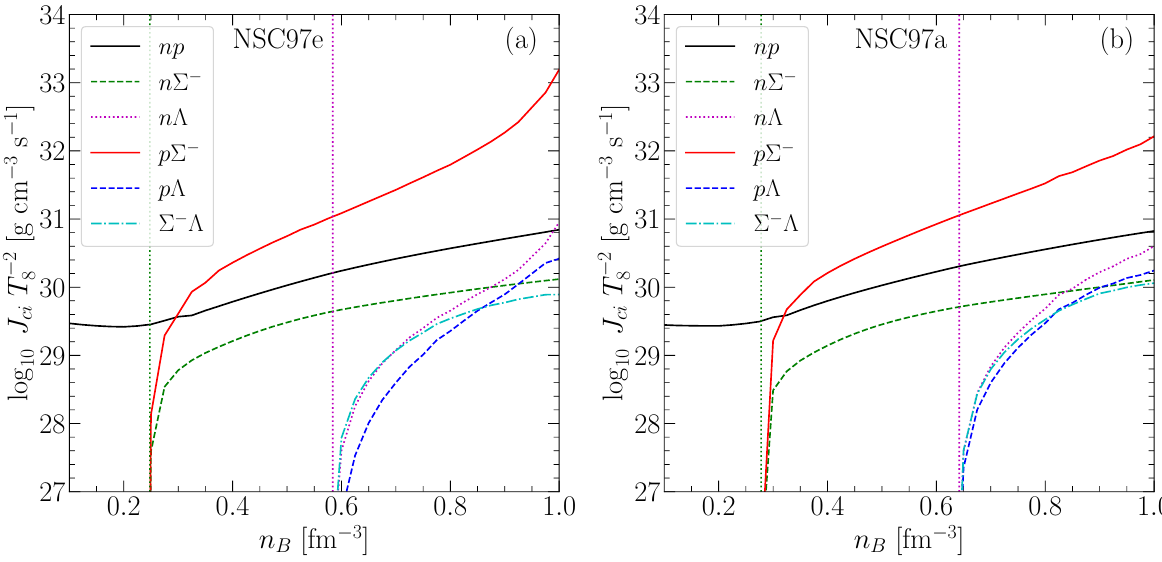
Figure 10. Momentum transfer rates J ci mediated by the strong interactions for the NSC97e (panel a ) and NSC97a (panel b ) models. The temperature-independent combination J ci T − 2 is shown. Different lines correspond to different baryon pairs as 8 shown in the legend. Vertical dashed lines indicate Σ − and Λ